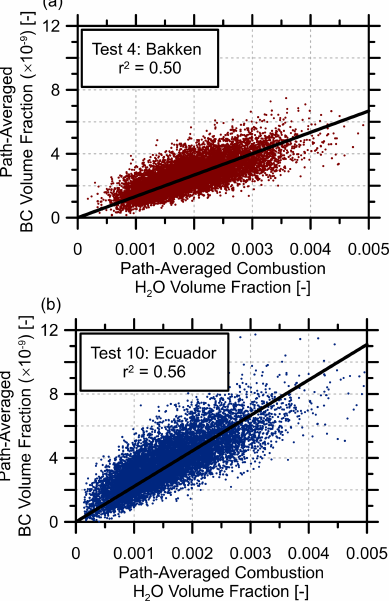
Figure 6. Sample scatter plots of path-averaged produced black carbon (BC) and H 2 O volume fractions for (a) Bakken fuel test 4 (40SLPM, 25.4mm burner) and (b) Ecuador fuel test 10 (40SLPM, 76.2mm